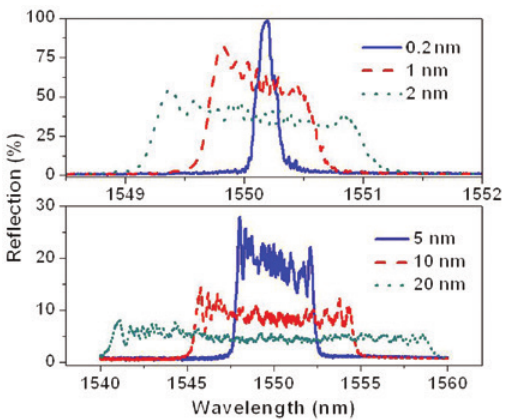
Figure 17: Reflection spectra of chirped WBGs fabricated using the modulated burst method in a fused silica